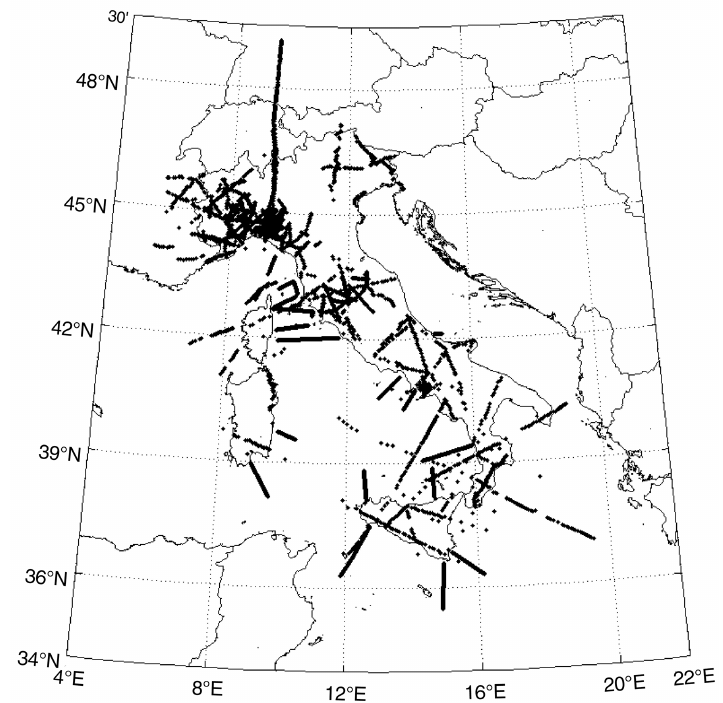
Fig. 1. Location map of the DSS and wide-angle seismic